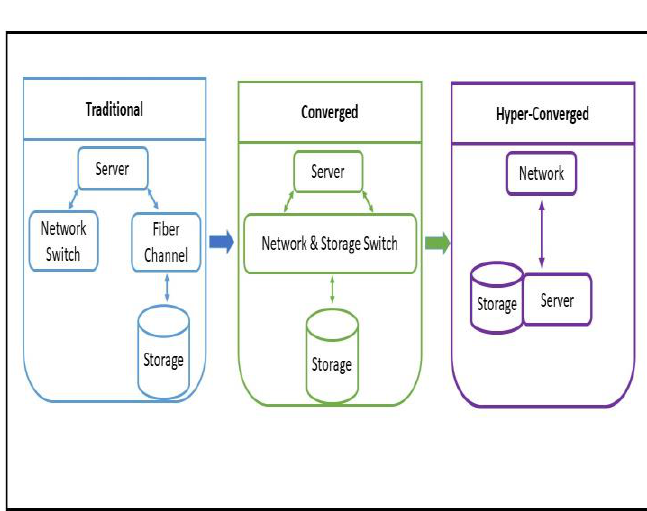
Figure 2. Evolution of